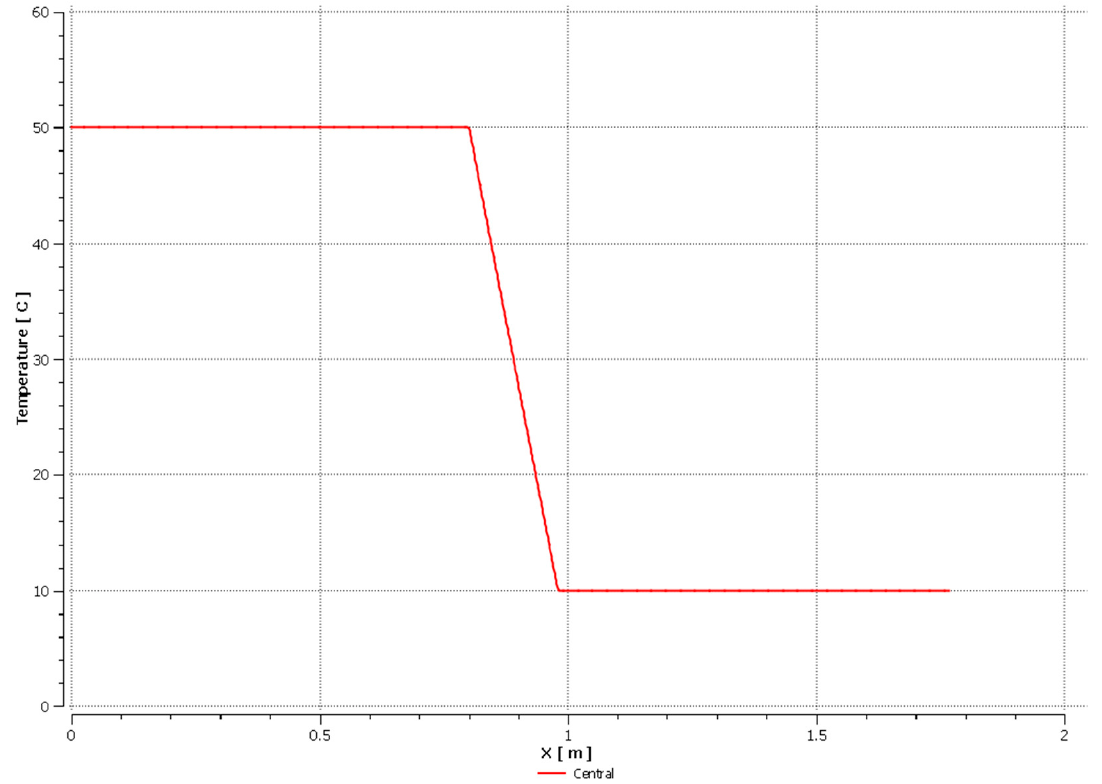
Figure 6. Temperature distribution along the height of the heat pipe’s wall.